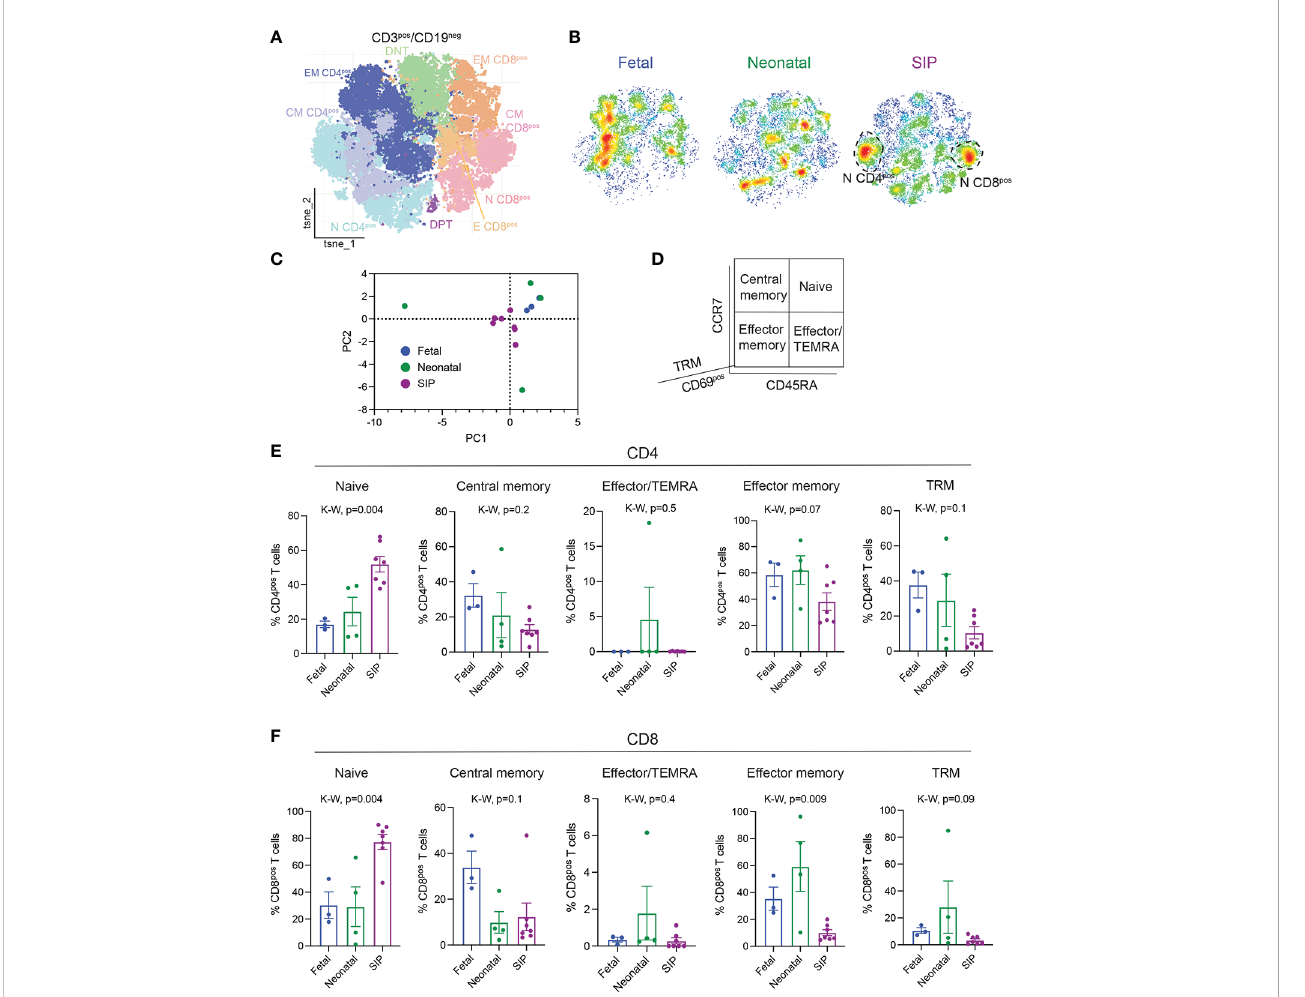
FIGURE 2 In fl ux of naïve CD4 + and CD8 + T cells in SIP-affected mucosa. (A) t-stochastic neighborhood embedding (tSNE) of all CD3 + CD19 - cells. (B) Density plots by group fetal n=3, neonatal n=4, SIP n=7 of CD3 + CD19 - cells. (C) Principal component analysis of CD3 + clusters (Figures 2A, S2A) generated in GraphPad Prism © 9 (see methods). (D) T cell populations are de fi ned by CD45RA, CCR7, CD69 expression. (E, F). Naïve (CD45RA + CCR7 + ), central memory (CM, CD45RA - CCR7 + ), effector/TEMRA (effector memory (CD45RA - CCR7 - ), and tissue resident memory (TRM, CD69 + CD45RA - CCR7 - ) expressed as a percentage of CD4 + T cells (E) and CD8 + T cells (F ). Each dot represents 1 case (fetal n=3, neonatal n=4, SIP n=7). p-value, K-W Kruskal- Wallis